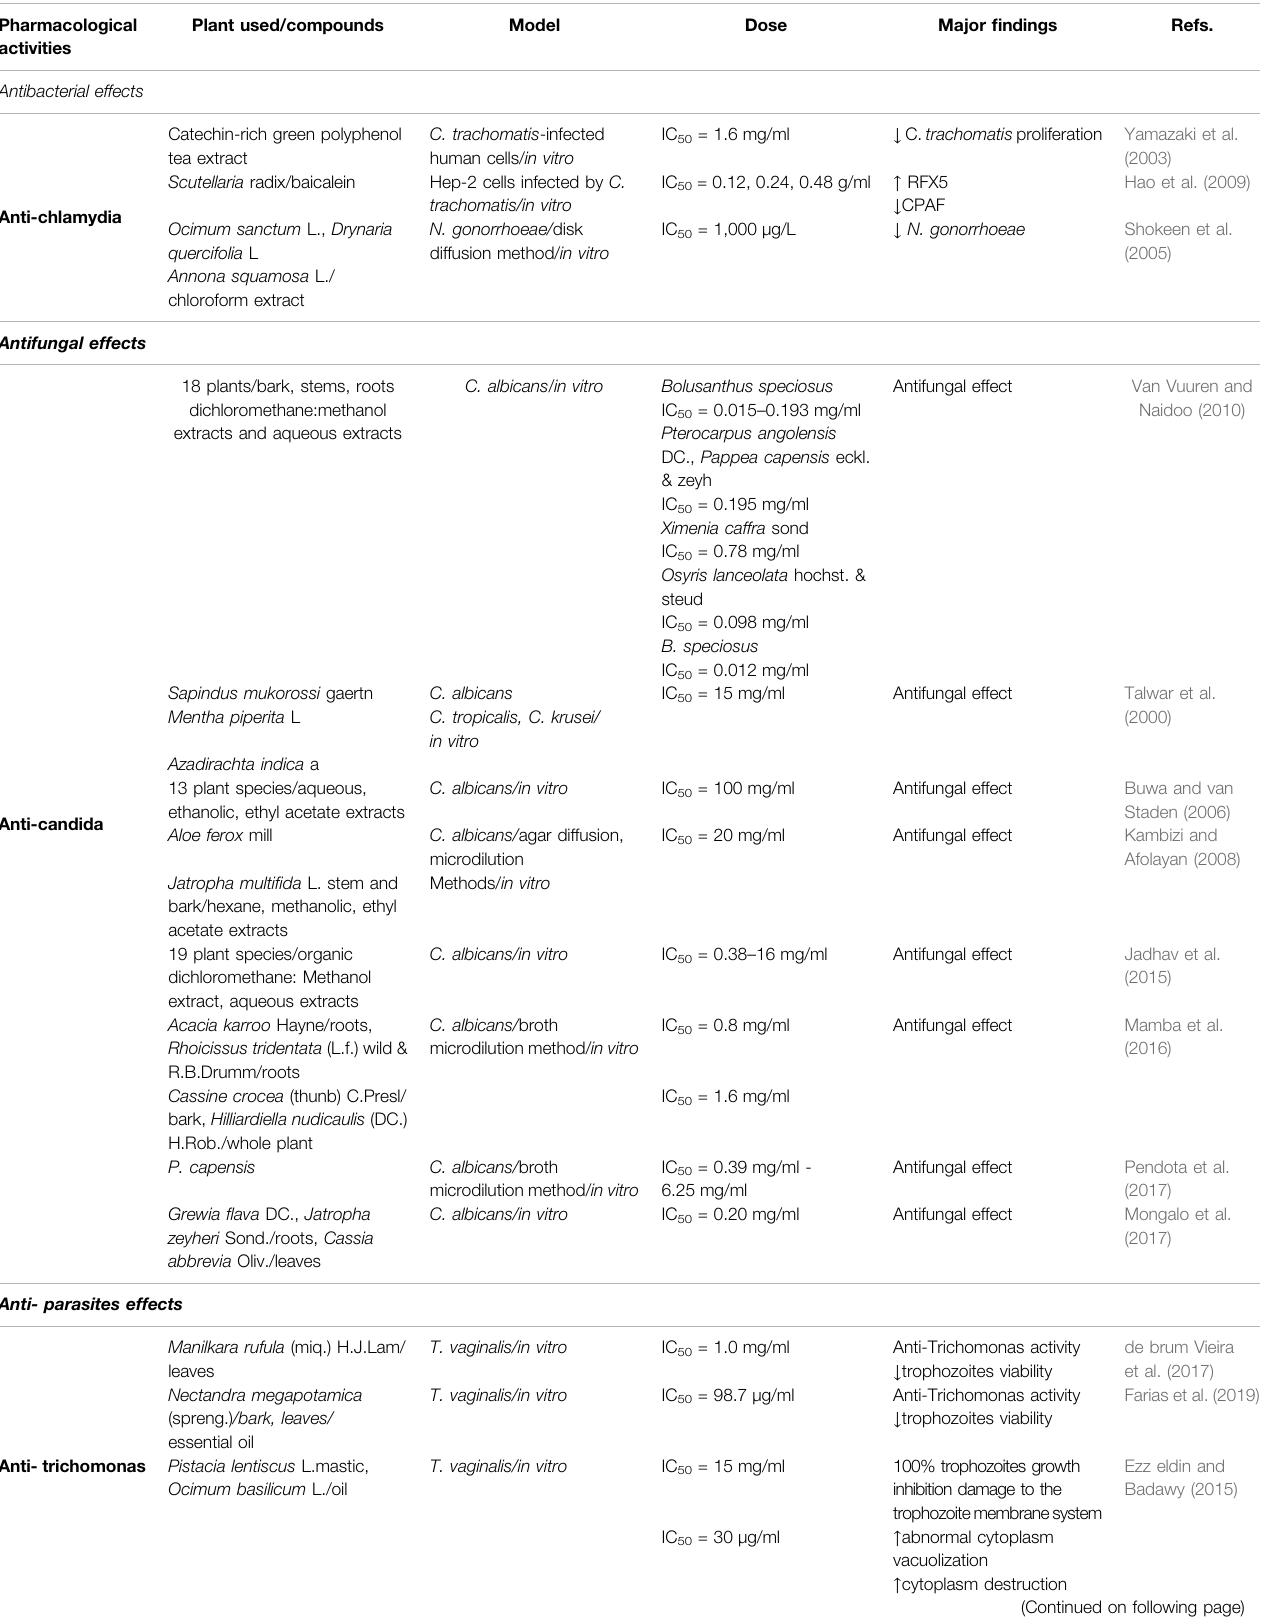
TABLE 2 | Pharmacological properties of selected plants/natural compounds against STDs pathogens. Pharmacological